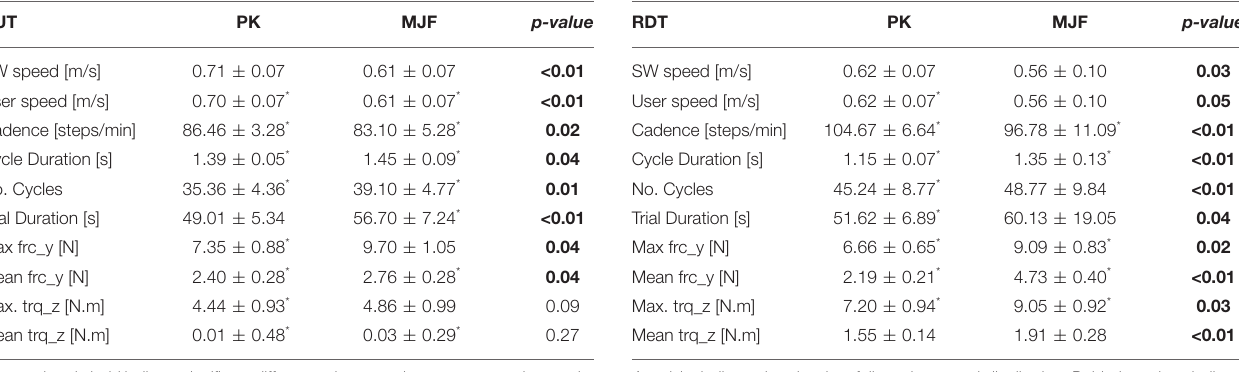
TABLE 4 | Results obtained for the Ramp Up Test (RUT). TABLE 5 | Results obtained in the Ramp Down Test